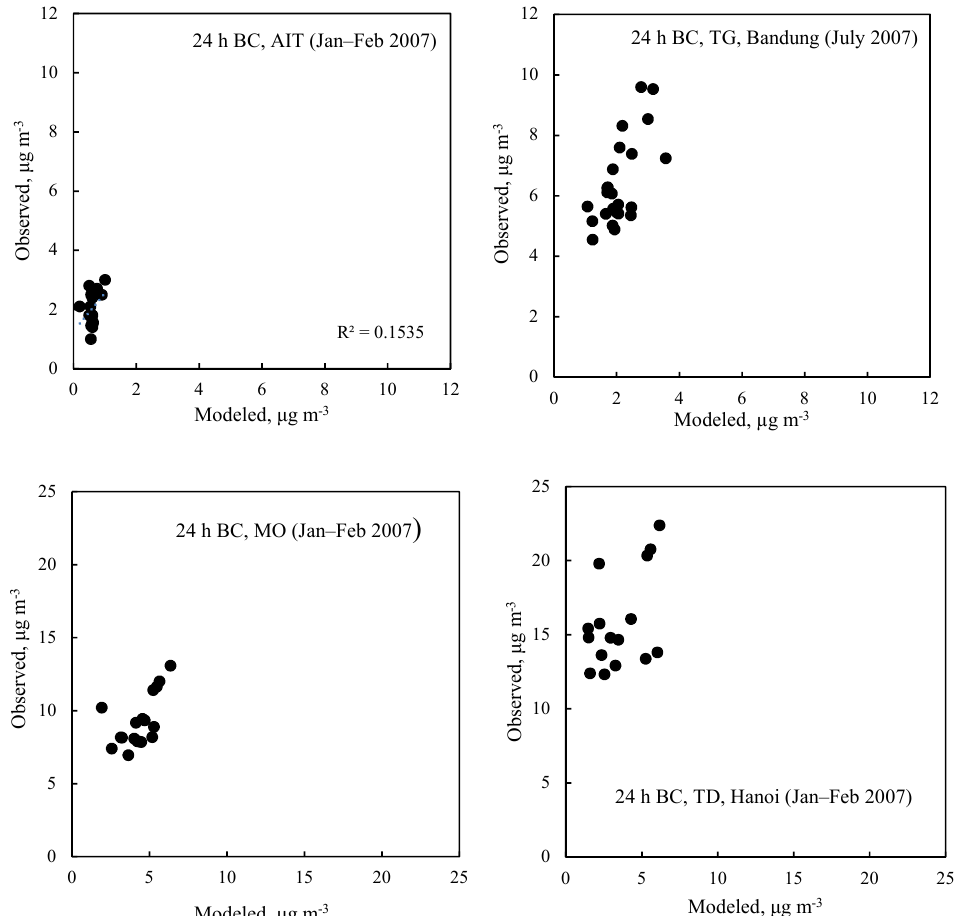
Figure 6. Comparison of 24h simulated and observed BC at four AIRPET sites in SEA domain,